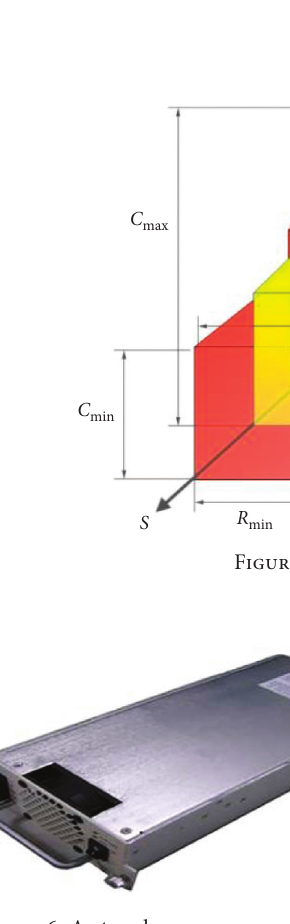
Figure 6: A step-down power source